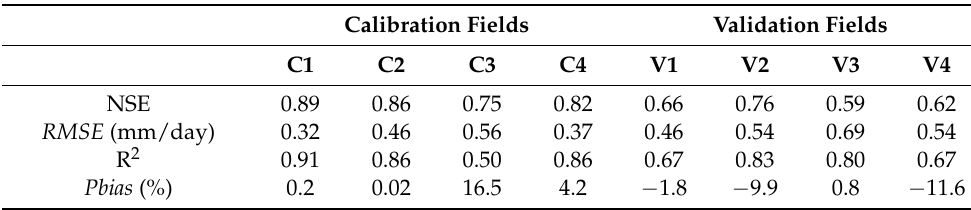
Table 3. Statistical values of the comparison between measured and modelled actual ET over the calibration and validation